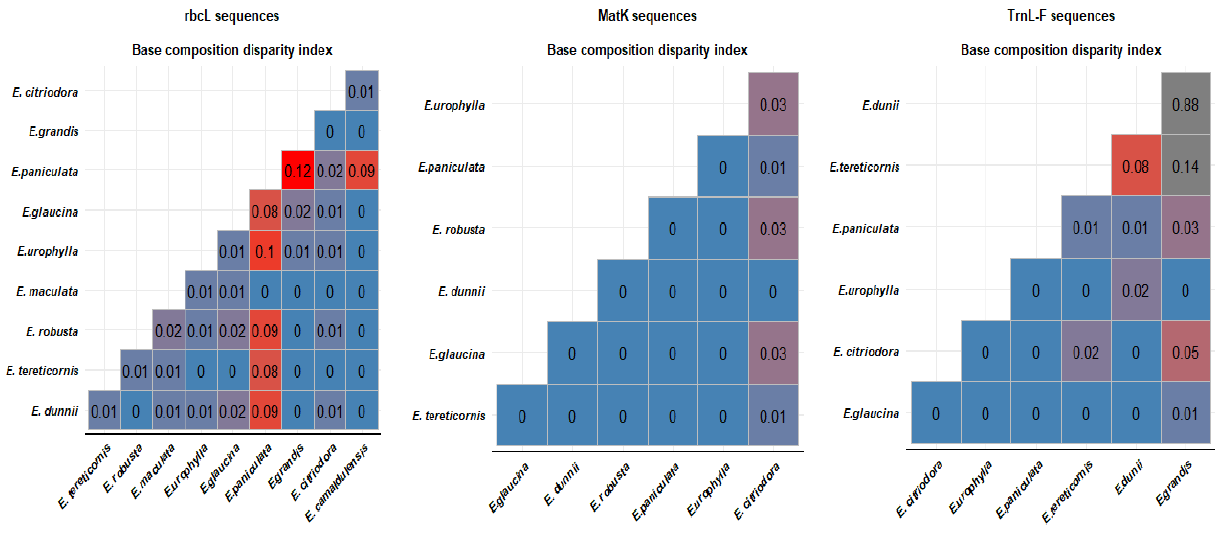
Figure 3. Nucleotide composition bias disparity index.